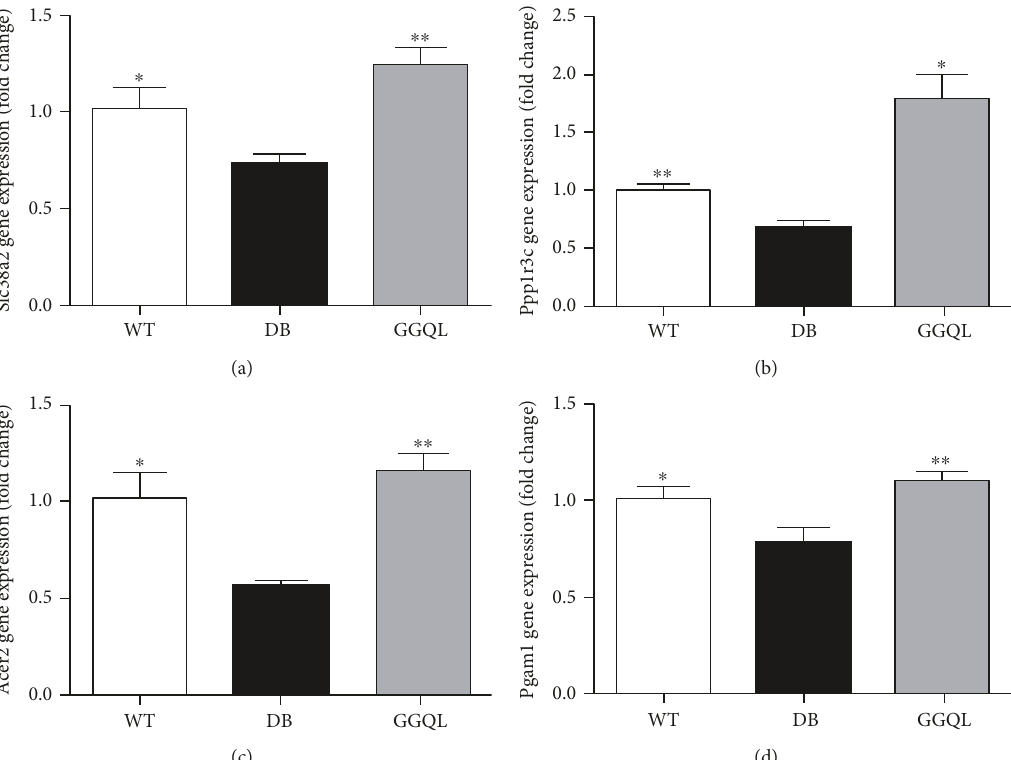
Figure 4: The results of RT-qPCR to validate di ff erentially expressed genes. The mRNA expressions of (a) Slc38a2, (b) Ppp1r3c, (c) Acer2, and (d) Pgam1 in each group ( n = 4 − 5 ). The DB group was the reference group to calculate P values, ∗ P < 0 05 and ∗∗ P < 0 01 .